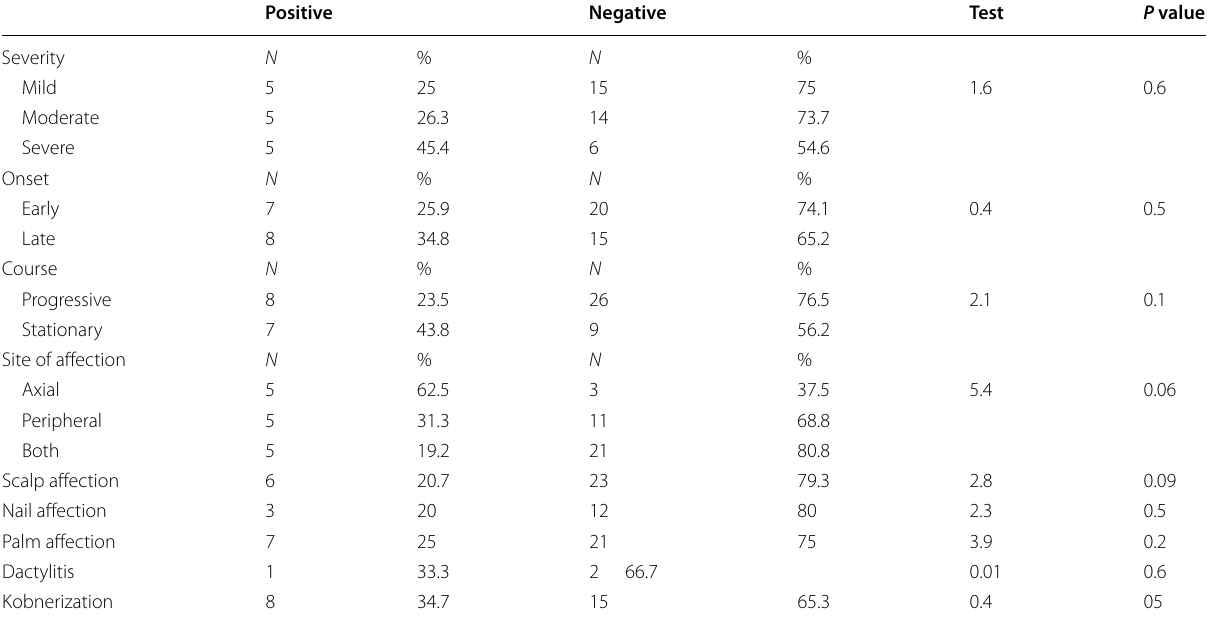
Table 6 Relationship of rheumatoid factor status to severity and pattern of psoriasis